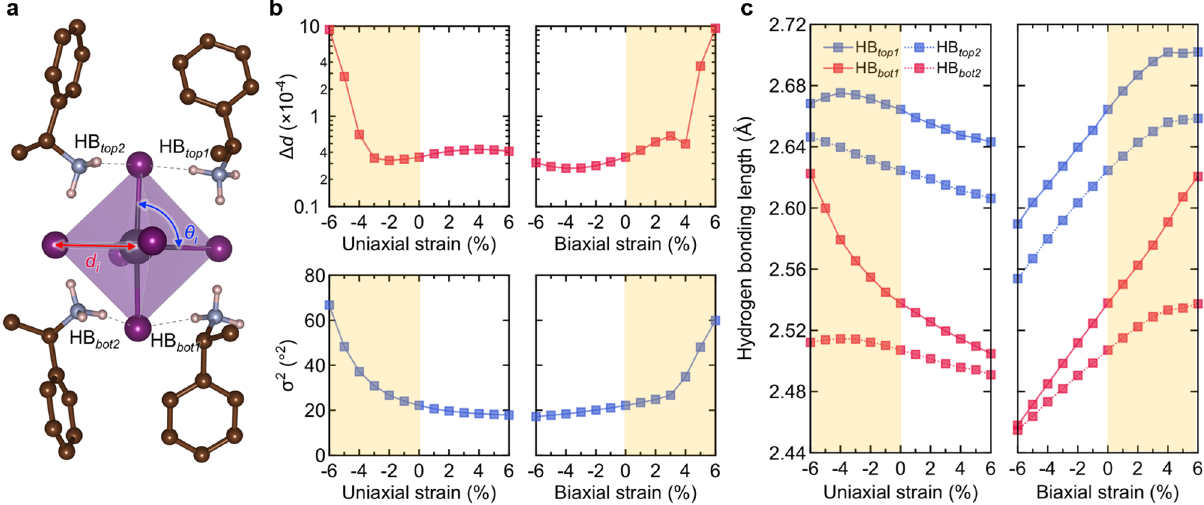
Fig. 3 Structure properties of chiral 2D OIHPs and the in fl uence of micro-strain on the speci fi c structural parameters by theoretical calculation. a Schematic illustration of intra-octahedron distortions and hydrogen bondings in DFT-optimized structure. b Bond length distortion and bond angle variance as a function of micro-strain. c Hydrogen-bonding length between the four different distinguishable hydrogen bondings in the unit cell of MBA 2 PbI 4 (denoted as HB top1 , HB top2 , HB bot1 , and HB bot2 ) and inorganic framework under uniaxial strain and biaxial strain. Highlighted yellow regions indicate the range where the lattice shrinkage occurs along the c-axis.